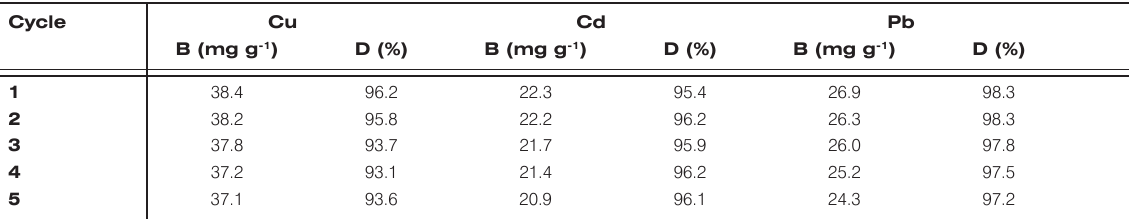
Table 2. The amount of metal ions adsorbed per gram of the matrix (mg g -1 ) and the desorption ratio (%) in repeated adsorption-desorption process.